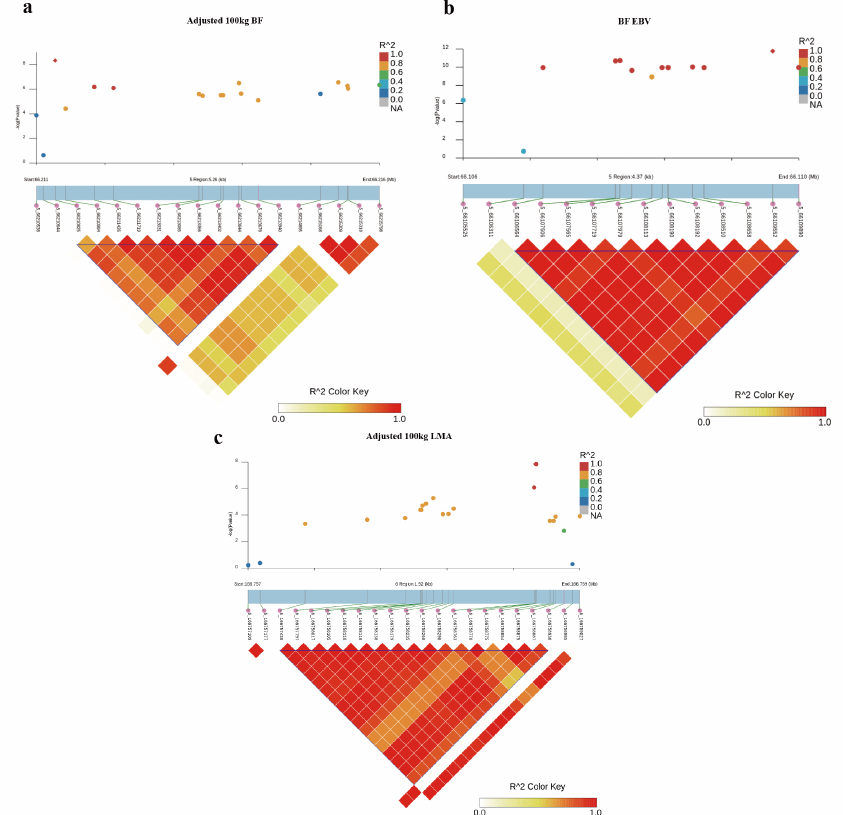
Figure 3. Haplotype block analysis of Top SNPs associated with BF and LMA traits. LD blocks are marked with triangles. LD (r 2 ) value between two SNPs were indicated by the colors of the squares. Diamond squares in the scatter plot indicate the most significant SNPs associated with traits. Scatter plot showing the LD between other SNPs and the most significant SNPs: ( a ) adjusted 100 kg BF; ( b ) adjusted 100 kg BF EBV; ( c ) adjusted 100 kg LMA